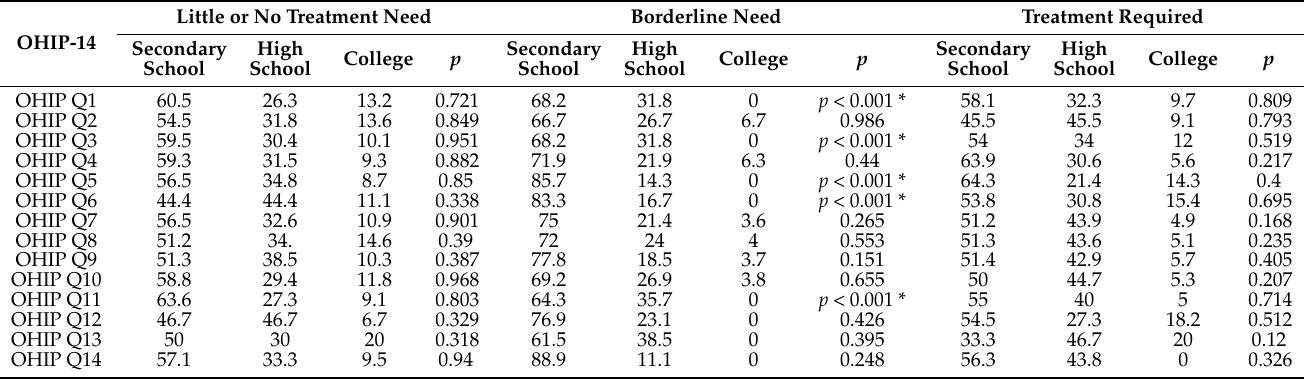
Table 7. Frequency of impact (in %) of each item of the OHIP-14 on IOTN-DHC in relation to the educational level of the study participants (N =